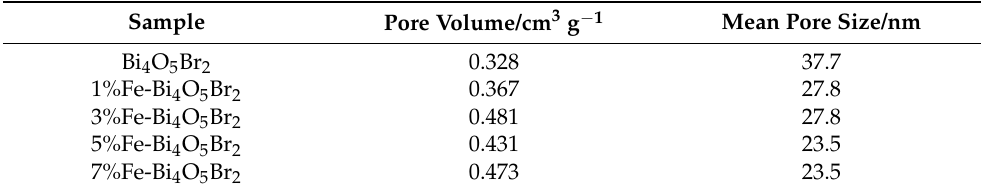
Table 1. Pore volume and mean pore size of samples.